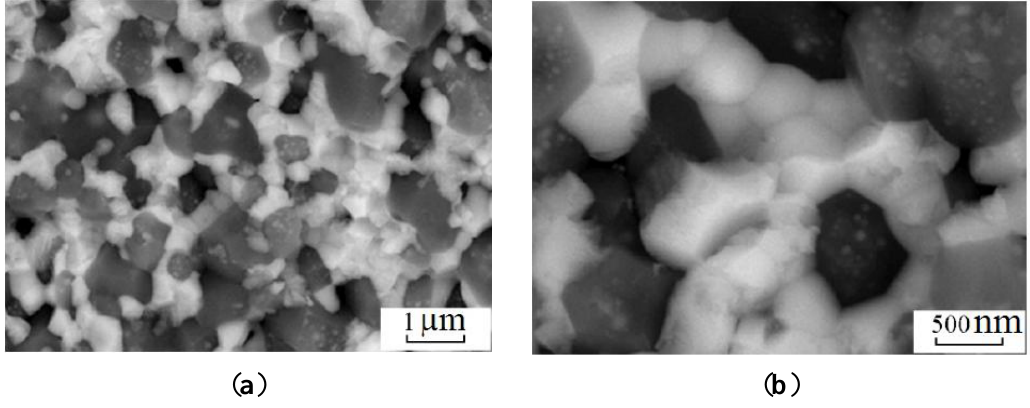
Figure 43. Microstructure of the sintered Al Т = 1500 °C: ( a ) 14000×; ( b ) 33000×.